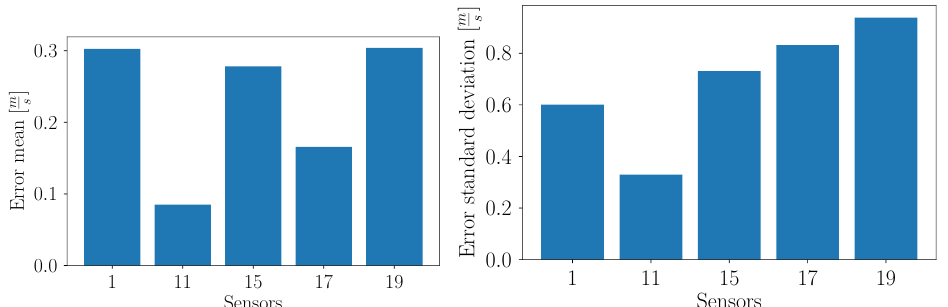
Figure 44. Mean and standard deviation of each sensor error for adjusted n in and n out